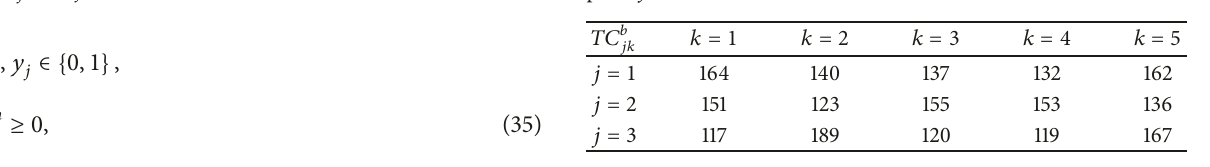
Table 5: Parameters of the base case, transportation unit cost from plant 𝑗 to warehouse 𝑘